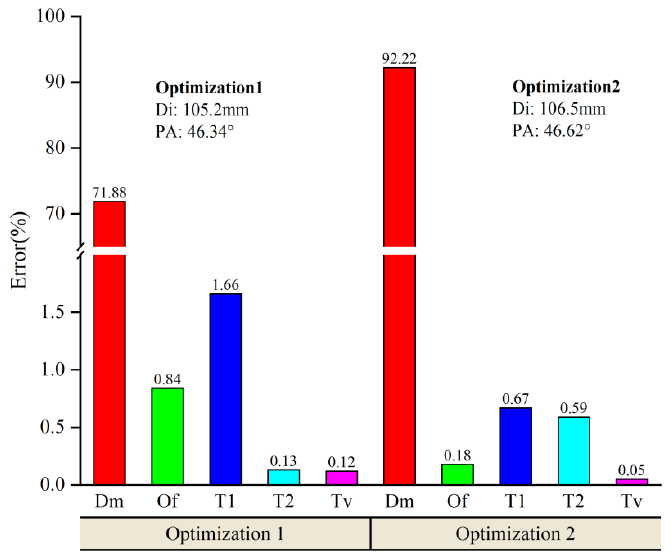
Figure 8. Comparison of this study’s error with that of the AQWA calculation results.